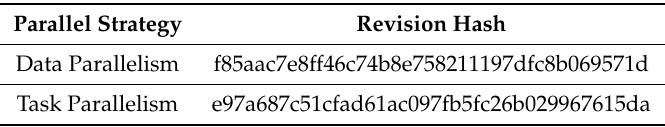
Table A1. Code Git revisions